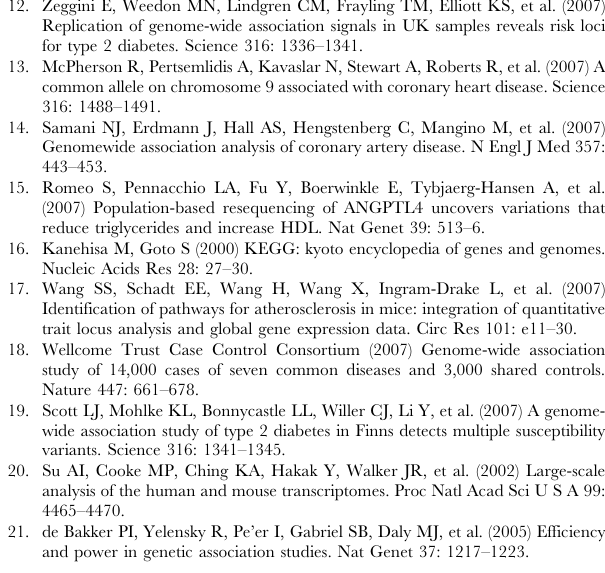
Table S1 Bins of SNPs with observed and expected Infinium conversion scores The distribution of SNPs binned according to Infinium score from 0.1 to 1 where a score of 0.8 indicates an 80% likelihood for conversion to a successful assay, 1.0 indicates an assay has , 100% theoretical score etc. A value of 1.1 indicates that an Infinium assay for SNPs has previously been successful in manufacture and analyses. Percentages are indicated in brackets.